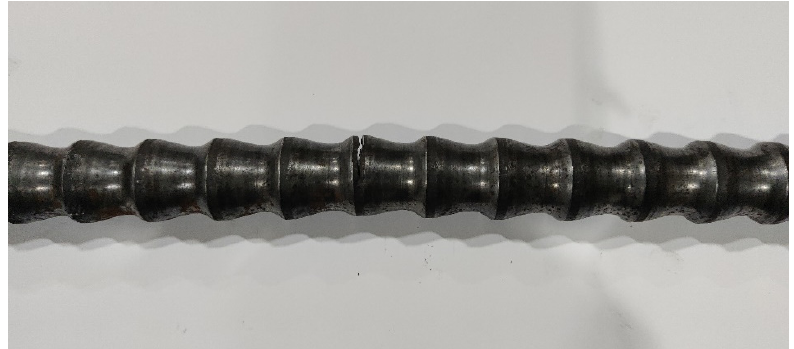
Figure 4. Fatigue fractured specimen.